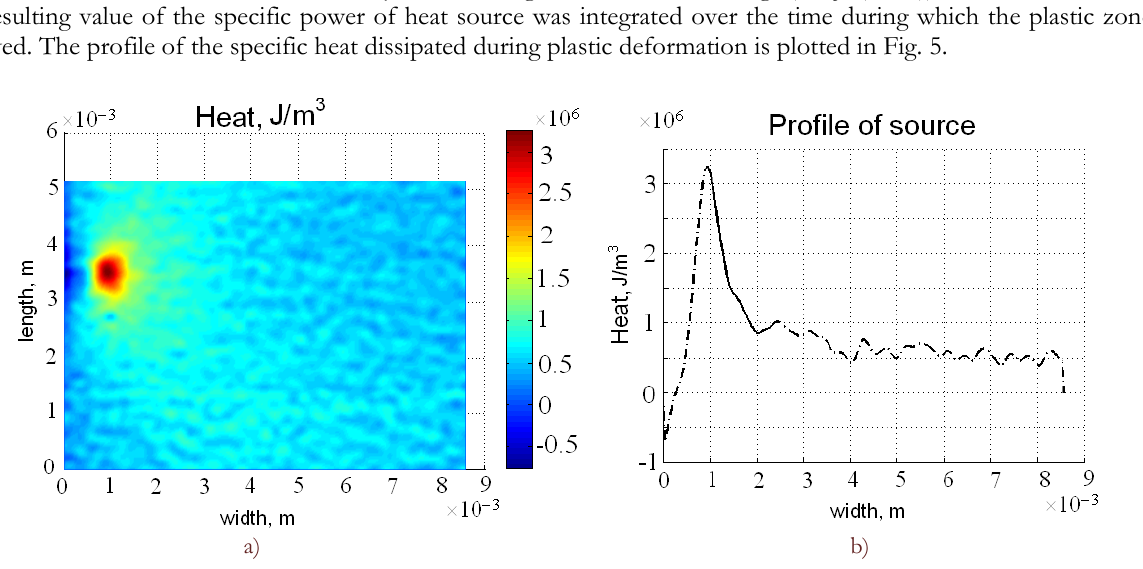
Figure 5: Specific heat (J/m 3 ) dissipated during plastic deformation (a) and its profile in the direction of crack propagation (b).